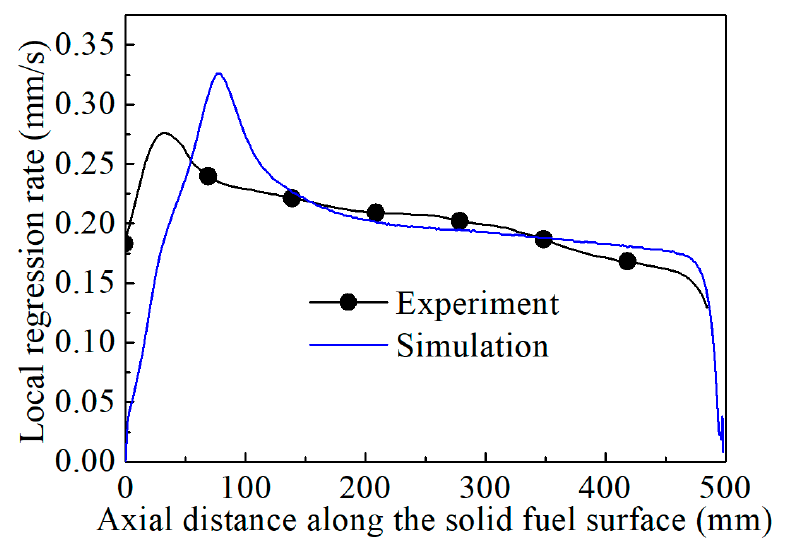
Figure 15. The regression rate of simulation and experiment.